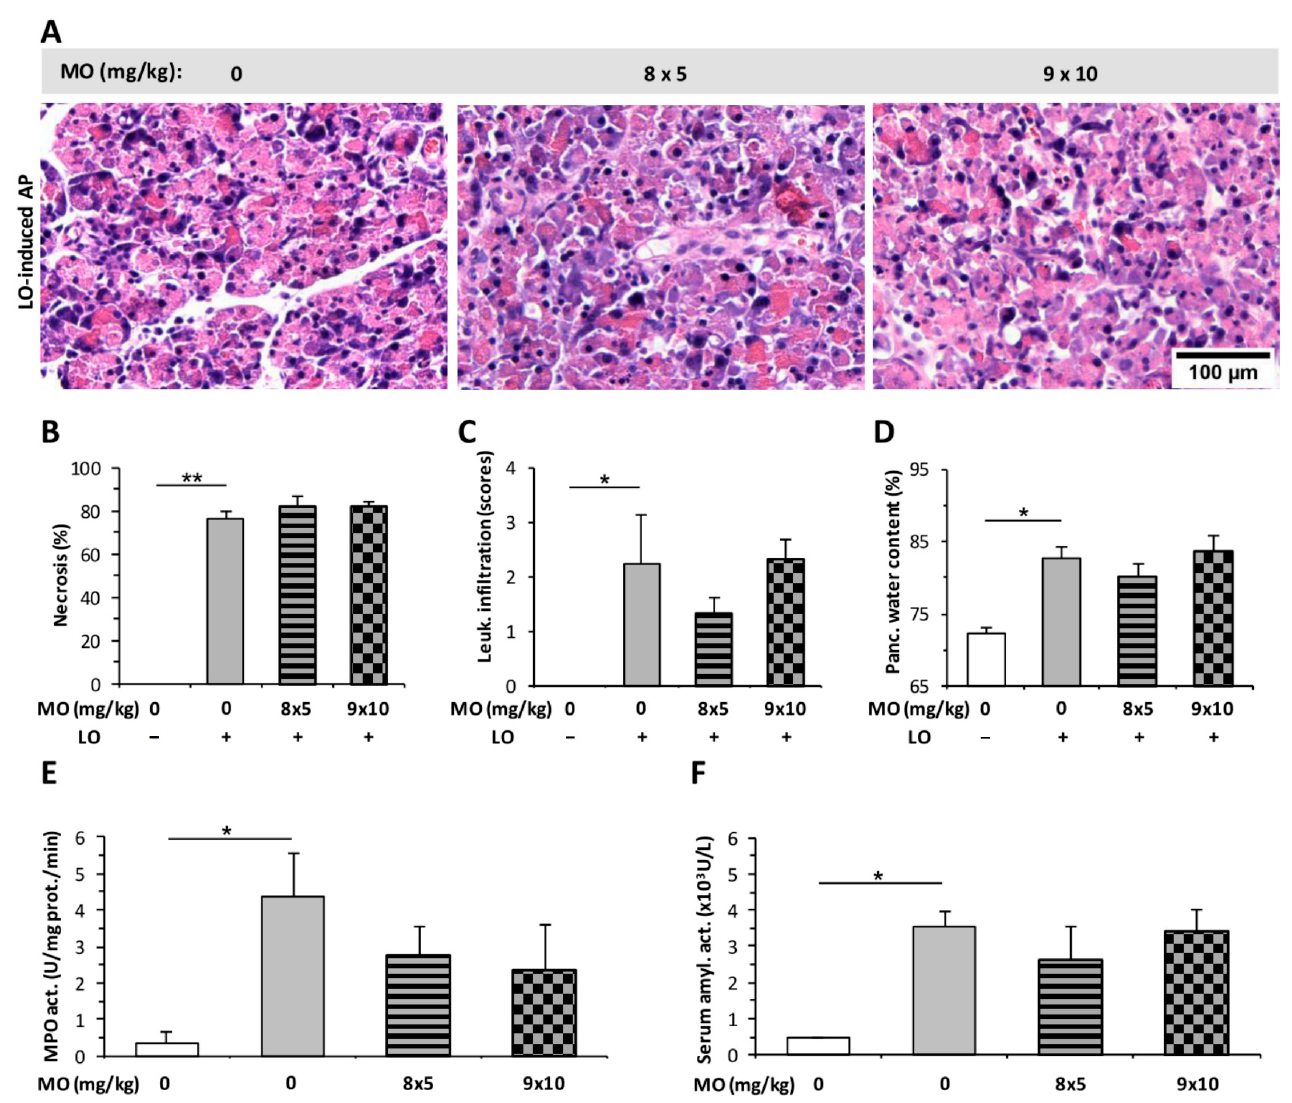
Figure 6. Morphine (MO) treatment does not affect the severity of L-ornithine (LO)-induced acute pancreatitis (AP). Rats were treated with 8 × 5 or 9 × 10 mg/kg MO i.p., whereas 3 g/kg LO-HCl (LO +) was used i.p. to induce AP. Control animals received physiological saline instead of LO (LO − ) or MO (0 mg/kg). Animals were sacrificed at 24 h after LO or physiological saline injection. ( A ) Representative histopathological images of pancreatic tissues of the treatment groups. Bar charts show the extent of pancreatic ( B ) necrosis, ( C ) leukocyte infiltration, ( D ) water content, ( E ) myeloperoxidase (MPO) activity, and ( F ) serum amylase activity measurements. Values represent mean with standard error, n = 6. Two-way ANOVA was performed followed by the Holm–Sidak post hoc test. * p < 0.05; ** p < 0.001.